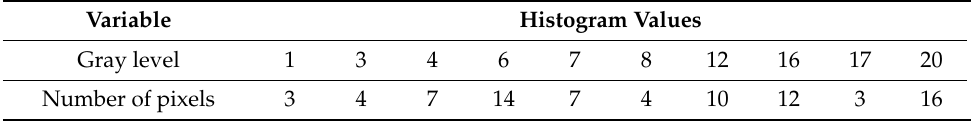
Table 1. Relationship between gray level and number of pixels.